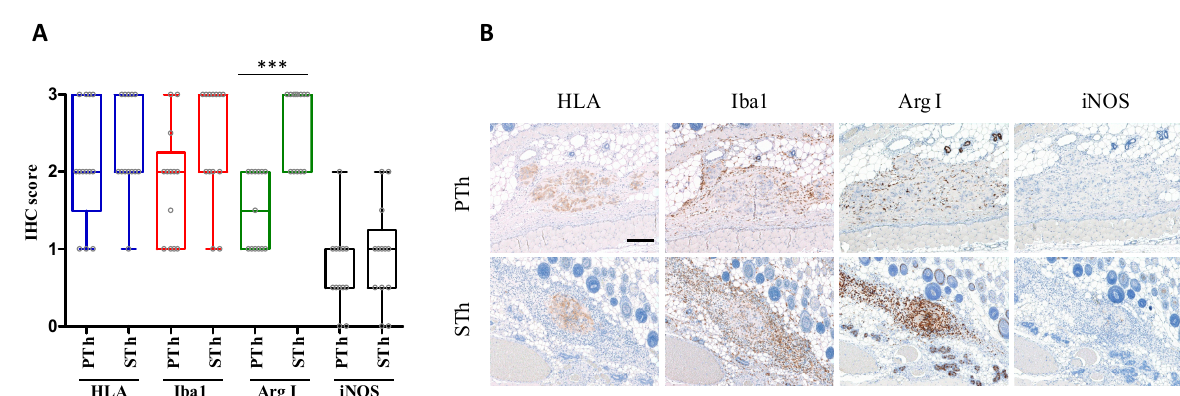
Figure 3. Immunohistochemical analysis of PTh and STh explants. ( A ) Boxplot with scatterplot showing IHC score relative to the markers HLA, Iba1, ArgI and iNOS evaluated in proliferating thyrocytes (PTh) and senescent thyrocytes (STh) explants. Scores has been defined as the percentage of positive areas (0 = absence; 0.5 = <5%; 1 = 5–10%; 2 = 10–25%; 3 = 25–50%). *** p -value < 0.0001. Samples from both experimental approaches (see Materials and Methods), displaying a comparable amount of HLA-positive cells were considered (PTh n = 13; STh n = 13). ( B ) Explants analysis performed at 1 day post-injection of PTh and STh (5 days 4OHT-treated) cells. HLA, Iba1, Arginase I, iNOS immunohistochemistry. 100× magnification, BAR = 200 µm.